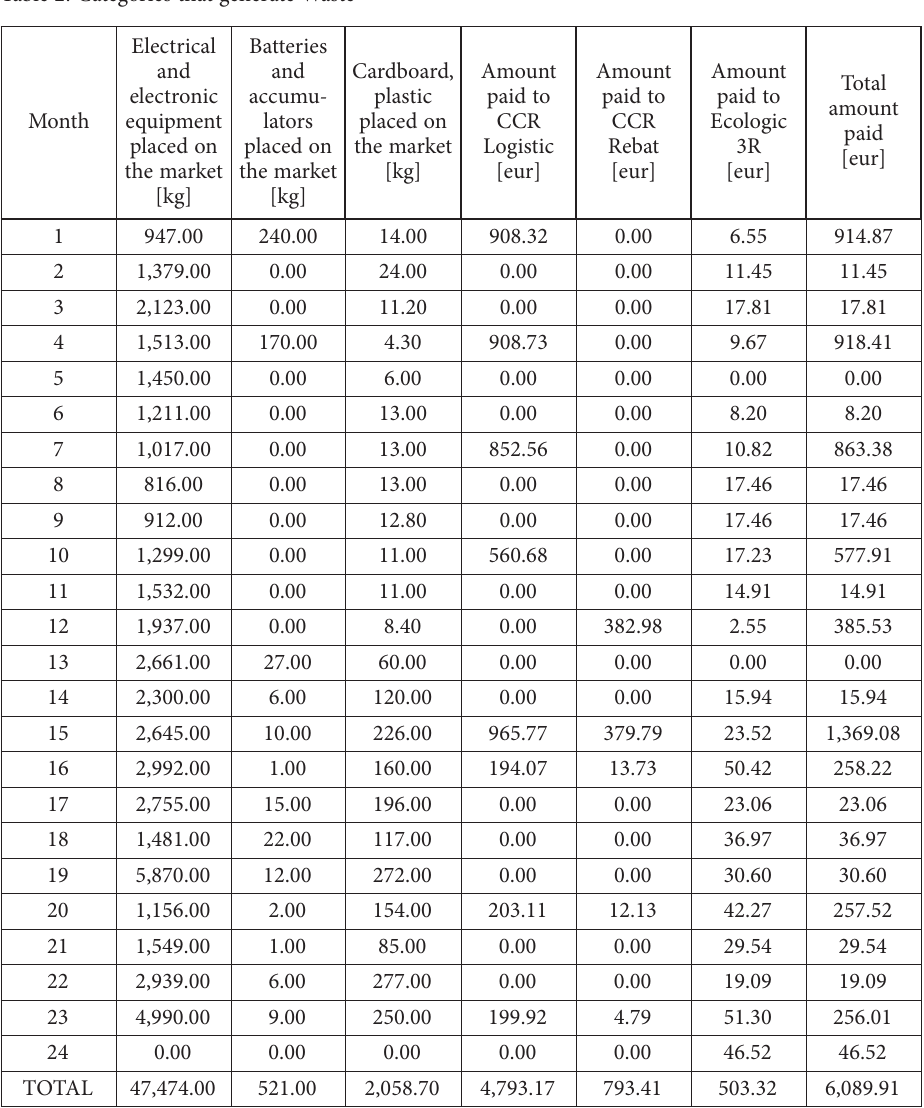
Table 2. Categories that generate Waste Electrical Month